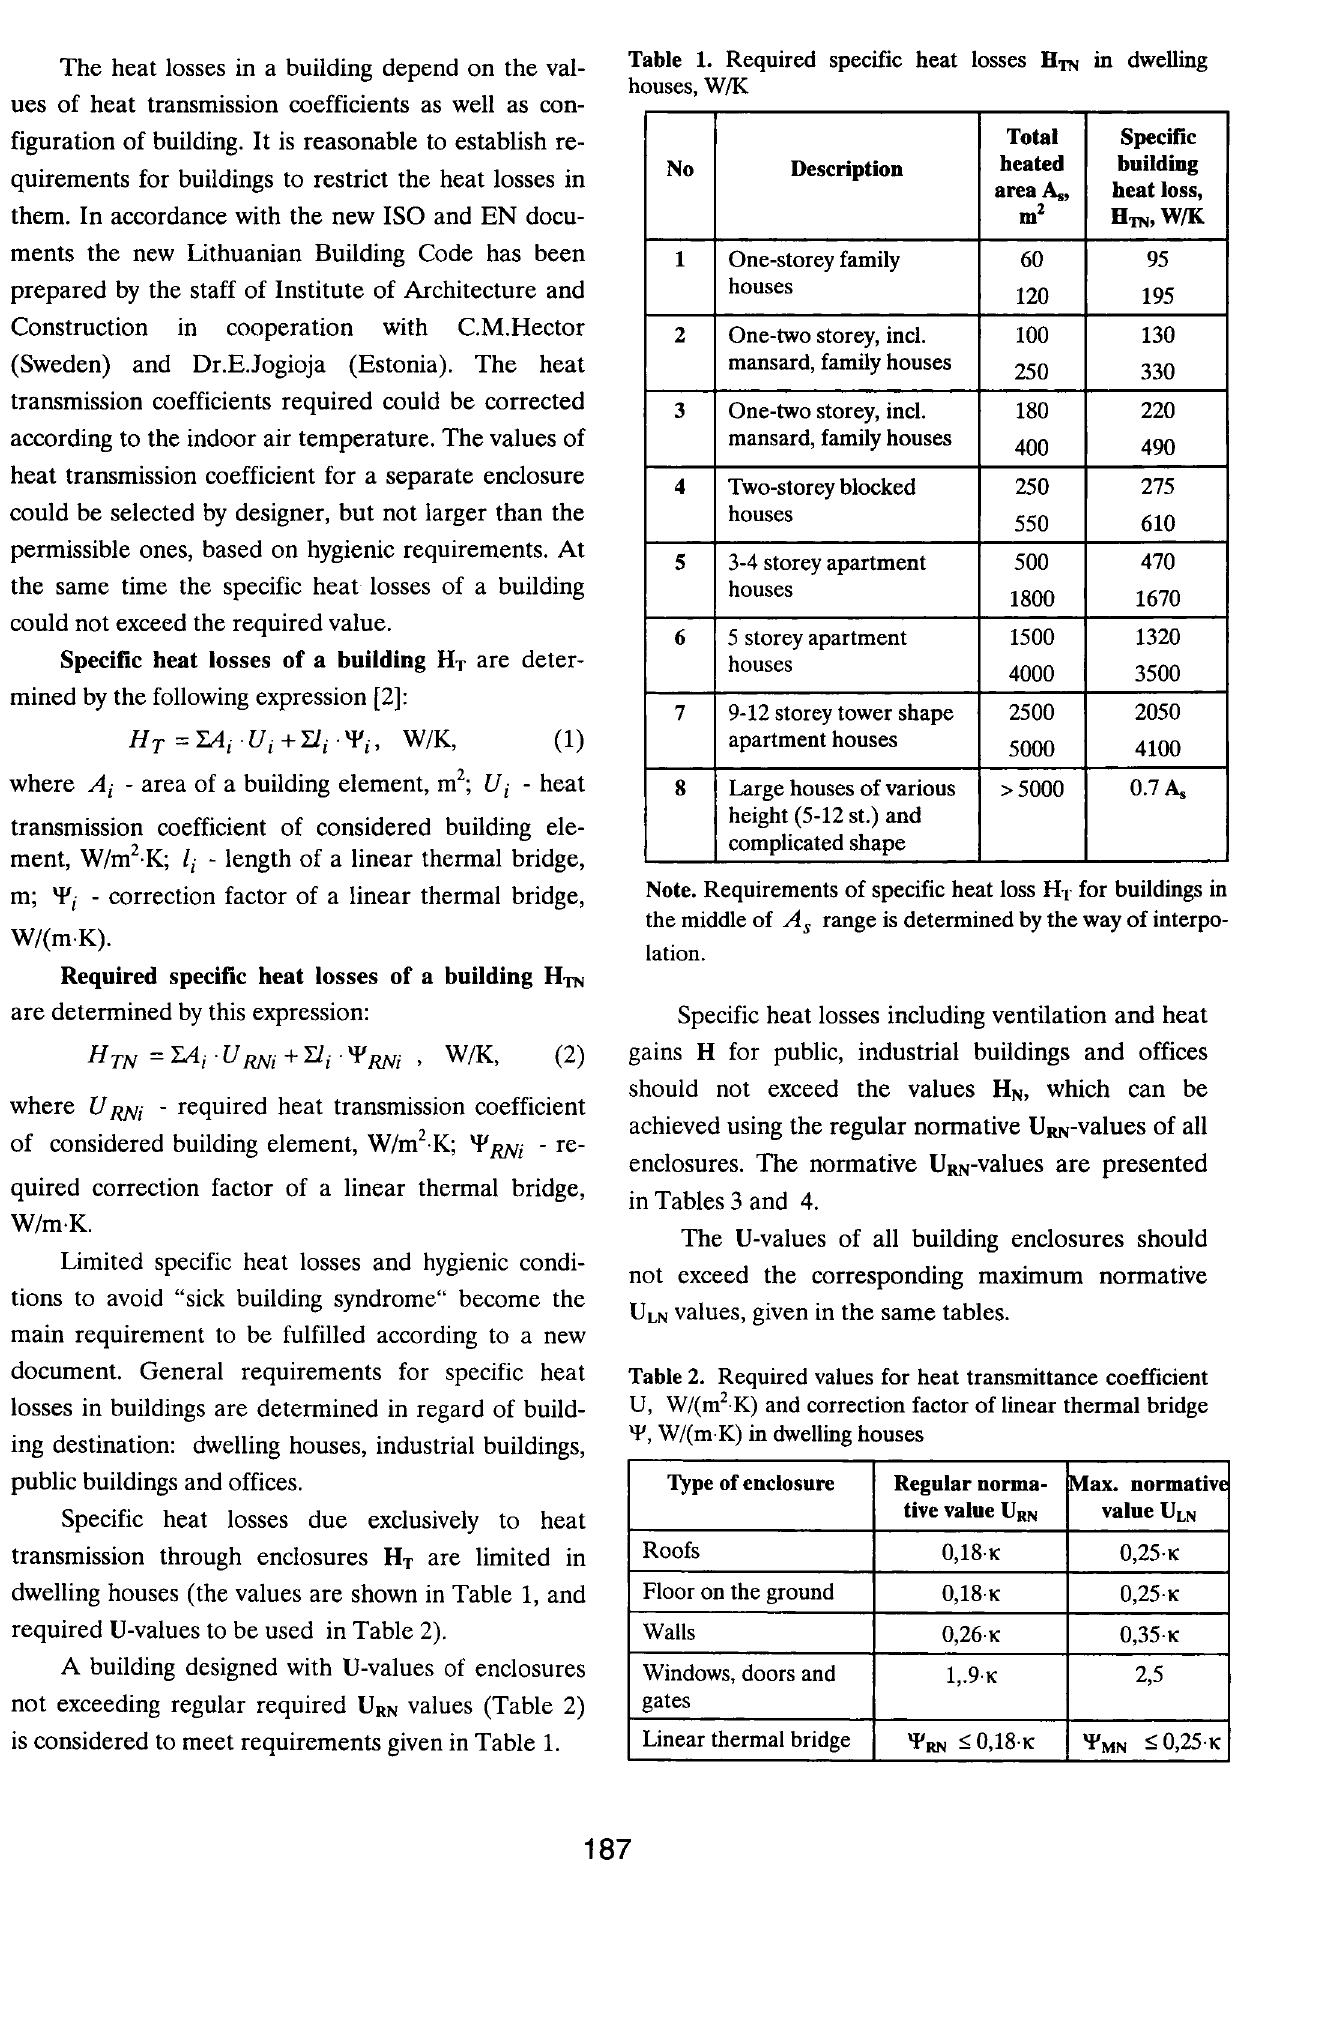
Table 1. Required specific heat losses BTN in dwelling houses, W/K